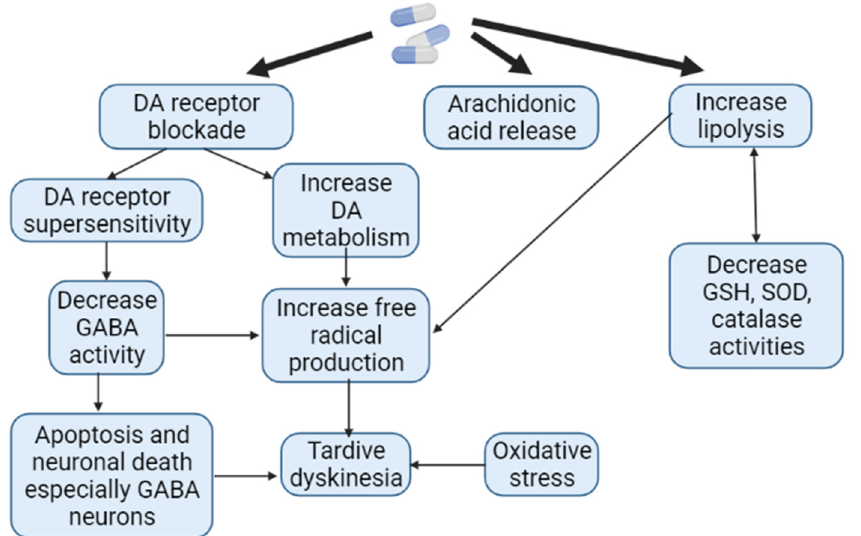
Figure 7. Pathogenesis of antipsychotic-induced tardive dyskinesia (Adapted from [119], Copyright year 2016, J. Exp. Pharmacol): Note: DA—dopamine; GABA—gamma aminobutyric acid; GSH— glutathione; SOD—superoxide